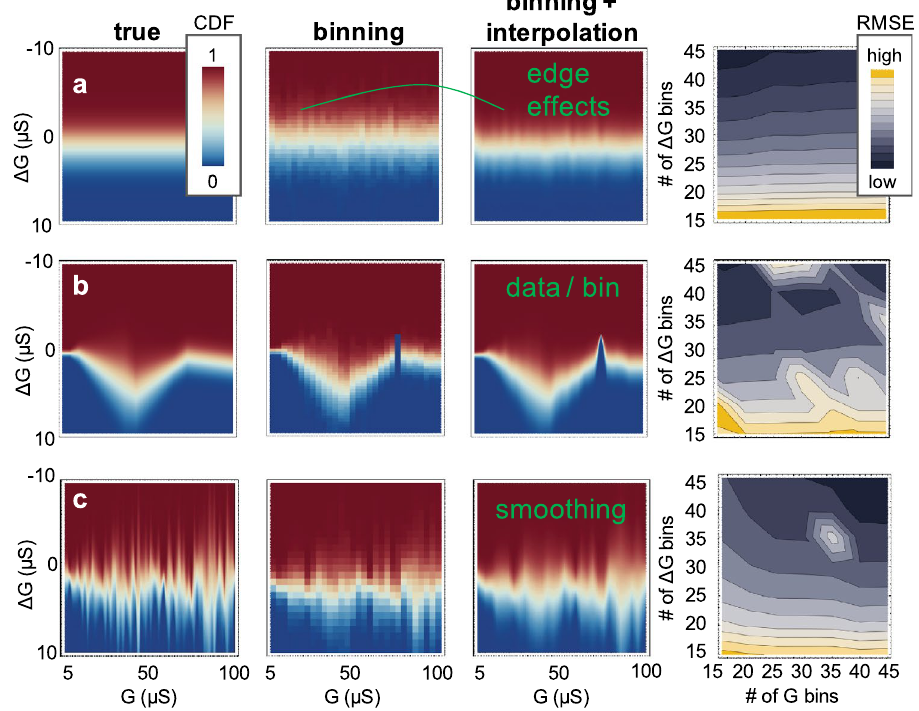
Figure 1. Binning challenges shown on synthetic distributions ( a ) with constant mean and SD; ( b ) an approximation of the model from ref 27 ; ( c ) randomly generated mean and